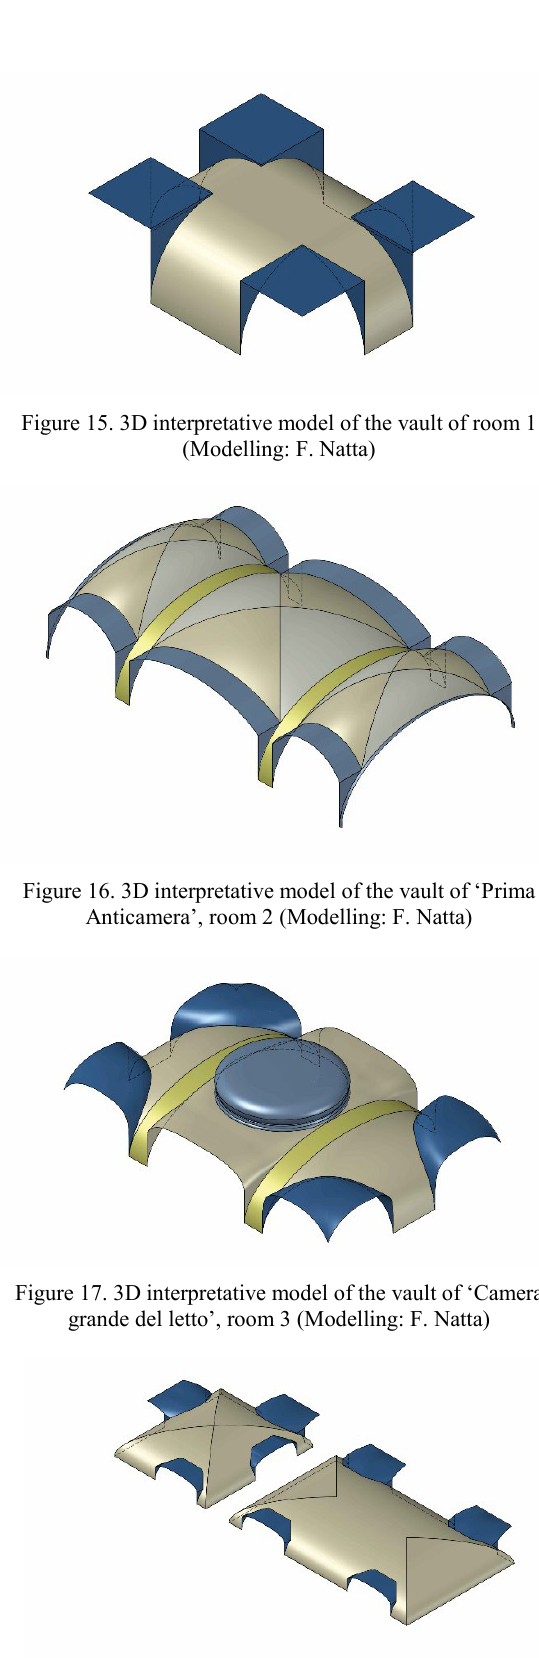
Figure 18. 3D interpretative model of the vaults of ‘Gabinetto di Cantone’, room 4, and of ‘Salotto contiguo al Gabinetto’, room 5 (Modelling: F.